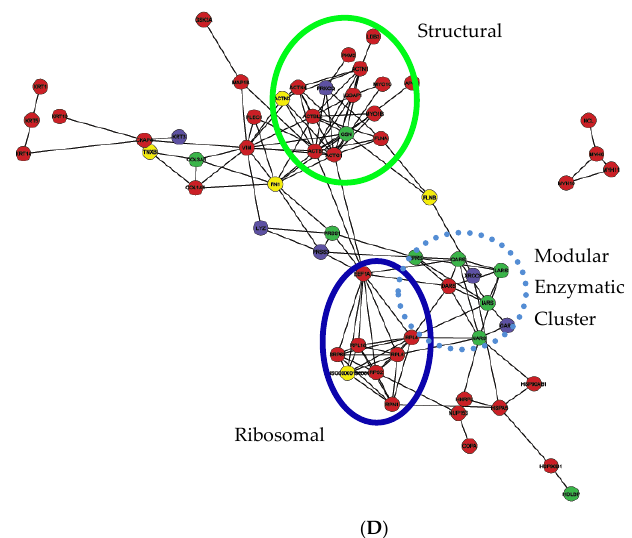
Figure 6. ( A ) Pre-induction media 1h (S0). Proteins are represented by coloured circular nodes. In total, 105 Red nodes denote S0 specific proteins. Connecting lines between each node indicate annotated interactions between identified proteins. Ribosomal cluster is encircled blue and the structural cluster is encircled green. ( B ) hADSCs differentiation media 1h (N1). Proteins are represented by coloured circular nodes. In total, 65 Red nodes denote shared S0 proteins from 5A. In total, 27 Green nodes denote N1 specific proteins. Connecting lines between each node indicate annotated interactions between identified proteins. Ribosomal cluster is encircled navy blue, the structural cluster is encircled green and modular enzymatic cluster is in the light blue dotted ring. ( C ) hADSCs differentiation media 6h (N6) Proteins are represented by coloured circular nodes. In total, 68 Red nodes shared S0 proteins from 5A. In total, 11 Green nodes shared N1 proteins from 5B. In total, 29 Yellow nodes are N6 specific proteins. Connecting lines between each node indicate annotated interactions between identified proteins. Ribosomal cluster is encircled blue, the structural cluster is encircled green and the modular enzymatic cluster is in the light blue dotted ring. ( D ) hADSCs differentiation media 12h (N12). Proteins are represented by coloured circular nodes. Red nodes shared S0 proteins from 5A. Green nodes shared N1 proteins from 5B. In total, 29 Yellow nodes are shared N6 proteins from 5C. Purple nodes are N12 specific proteins. Connecting lines between each node indicate annotated interactions between identified proteins. Ribosomal cluster is encircled blue, the structural cluster is encircled green and the modular enzymatic cluster is in the light blue dotted